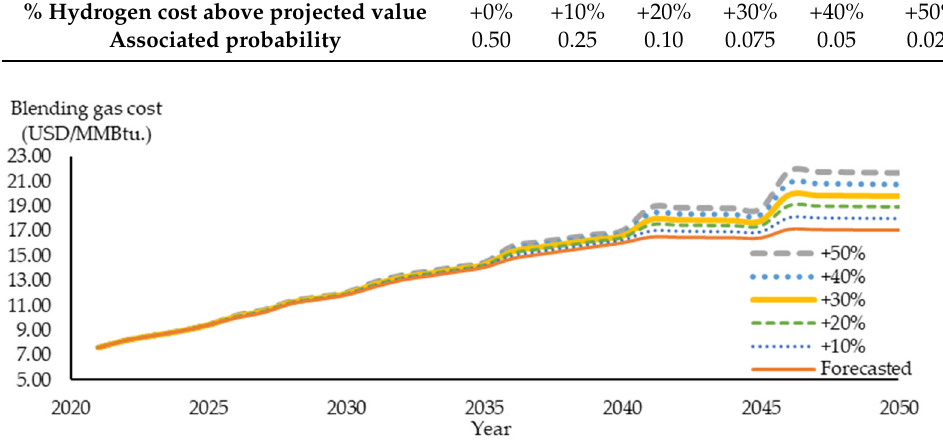
Figure 12. Example of cost of 75% maximum hydrogen blending case.